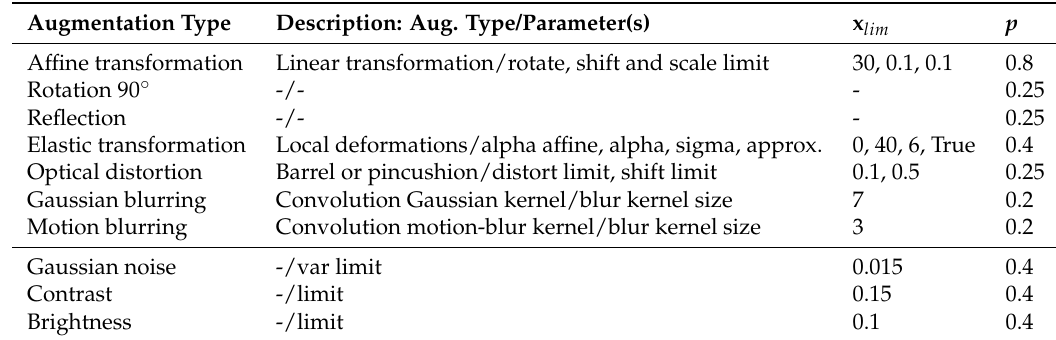
Table 2. Description of individual augmentations implemented using the albumentations framework. Augmentation